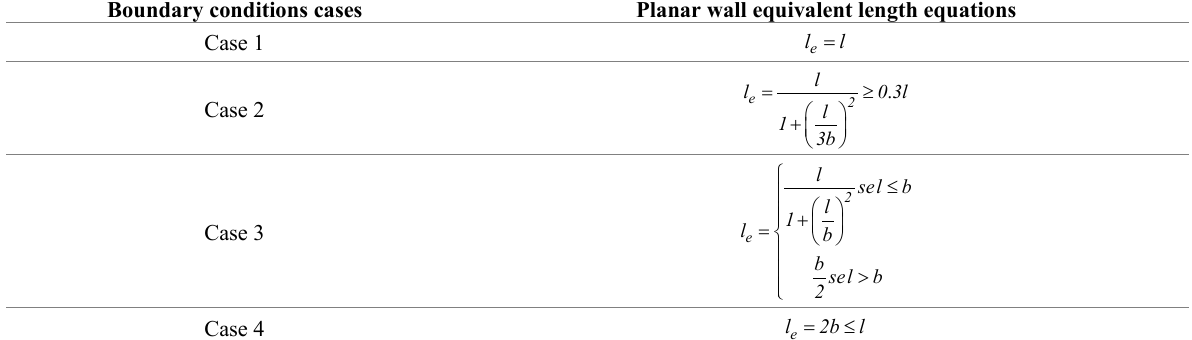
Table 1. Planar wall equivalent